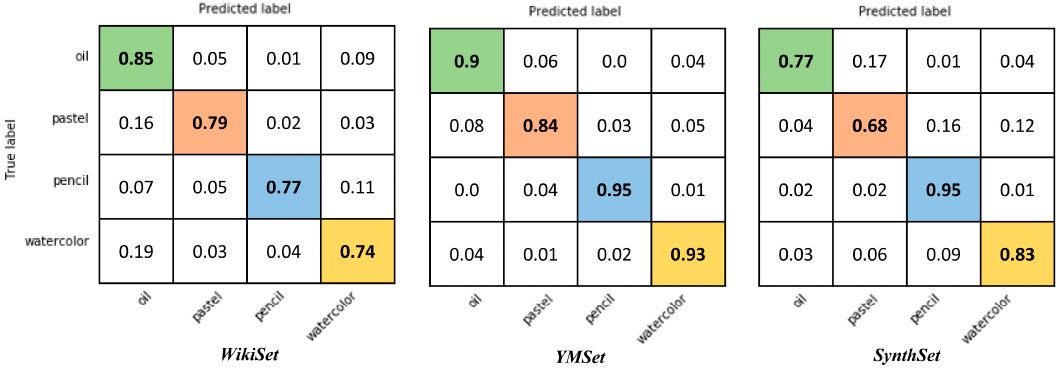
Figure 8. The confusion matrices from WikiSet , YMSet and SynthSet .